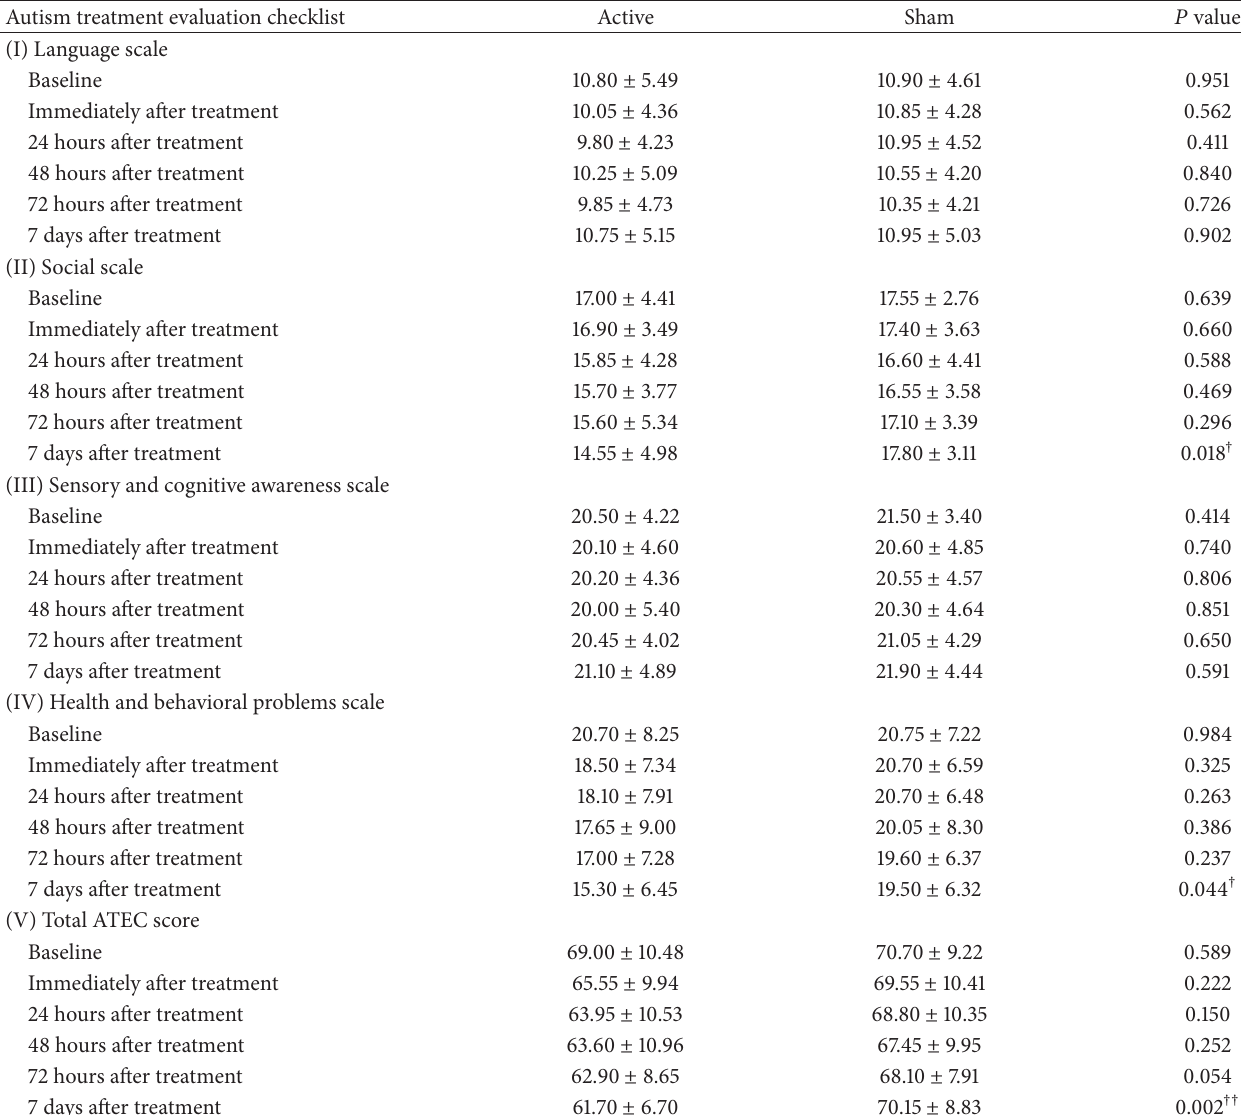
Table 3: Means and standard deviations of the autism treatment evaluation checklist (ATEC) scale scores at each assessment point for active and sham